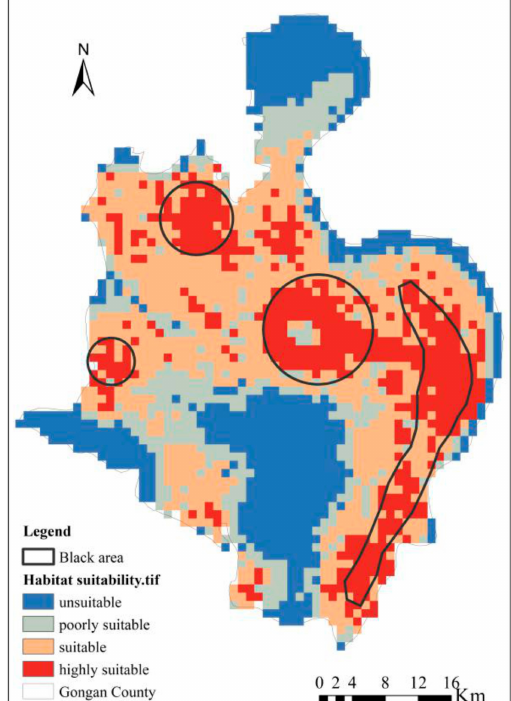
Figure 6. Predicted potential geographic distributions for O. hupensis snail using all occurrence records and environmental variables, by applying Maxent modeling at a 1-km